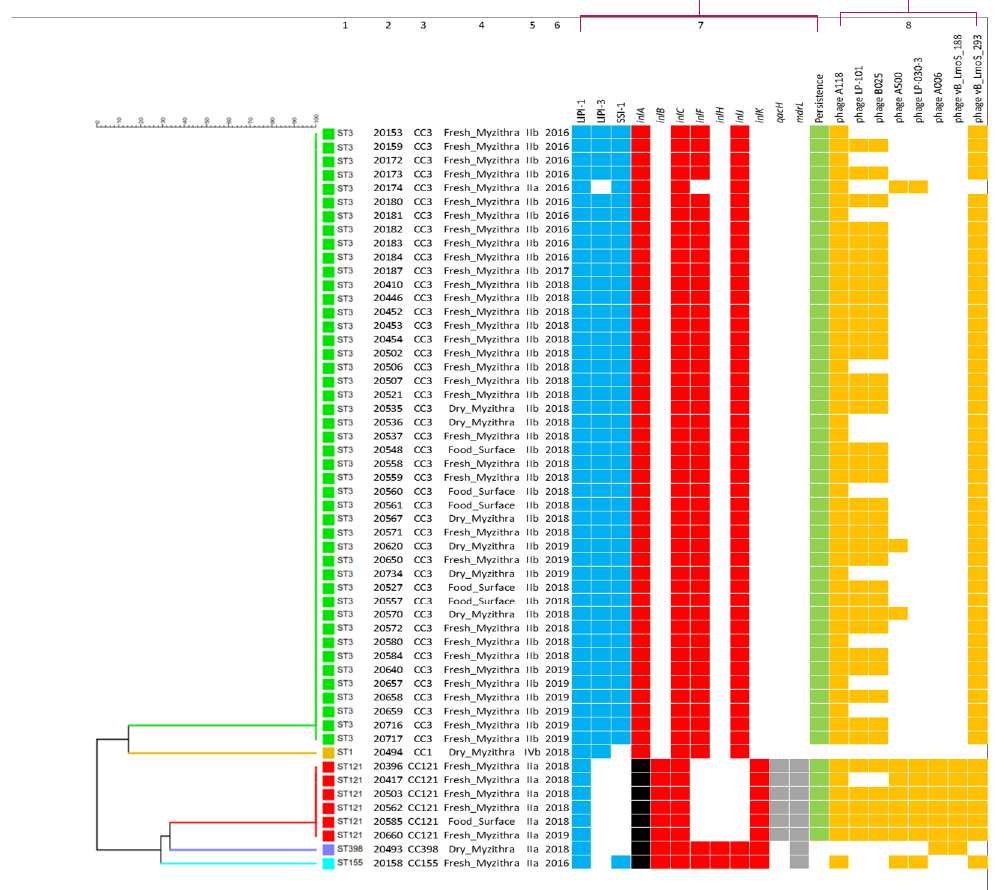
Figure 6. Dendrogram depicting the clustering of strains and clustering analysis of genes in L. monocytogenes isolates from Myzithra cheese and food processing surfaces. The heatmap shows the presence (color) or absence (no color) of the selected gene among the isolates. The black color indicates the presence of a truncated inlA gene. Column 1: Sequence type (ST), 2: Strain ID (AAL code), 3: Clonal complex (CC), 4: Isolation source (end-product or surface), 5: PCR-serogroup, 6: Year of strain isolation, 7: Detected genes and persistence trait, 8: Detected phages. Abbreviations for detected genes are given in the text.